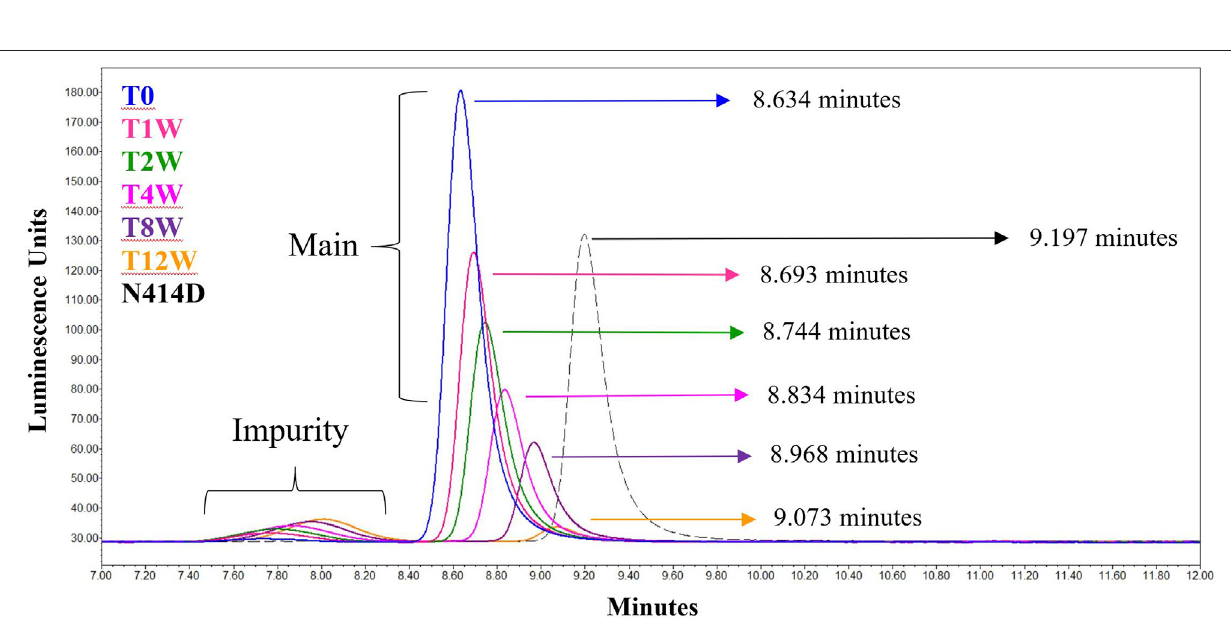
FIGURE 5 | AEX-HPLC of the N414D mutant overlaid with the singlicate AdC68 #1 accelerated stability time course. The timepoints in the accelerated stability study are labeled on the fi gure, with blue representing the pro fi le of the unstressed material. The gray dashed line represents the N414D mutant. The retention times for each time point and for the mutant are shown in the fi